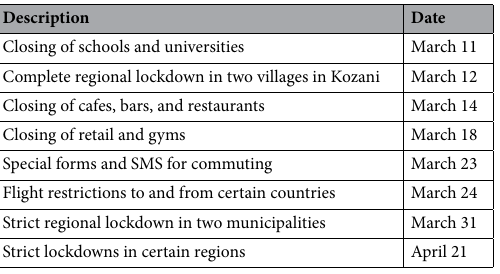
Table 1. Adopted measures considered in developing the NPIs